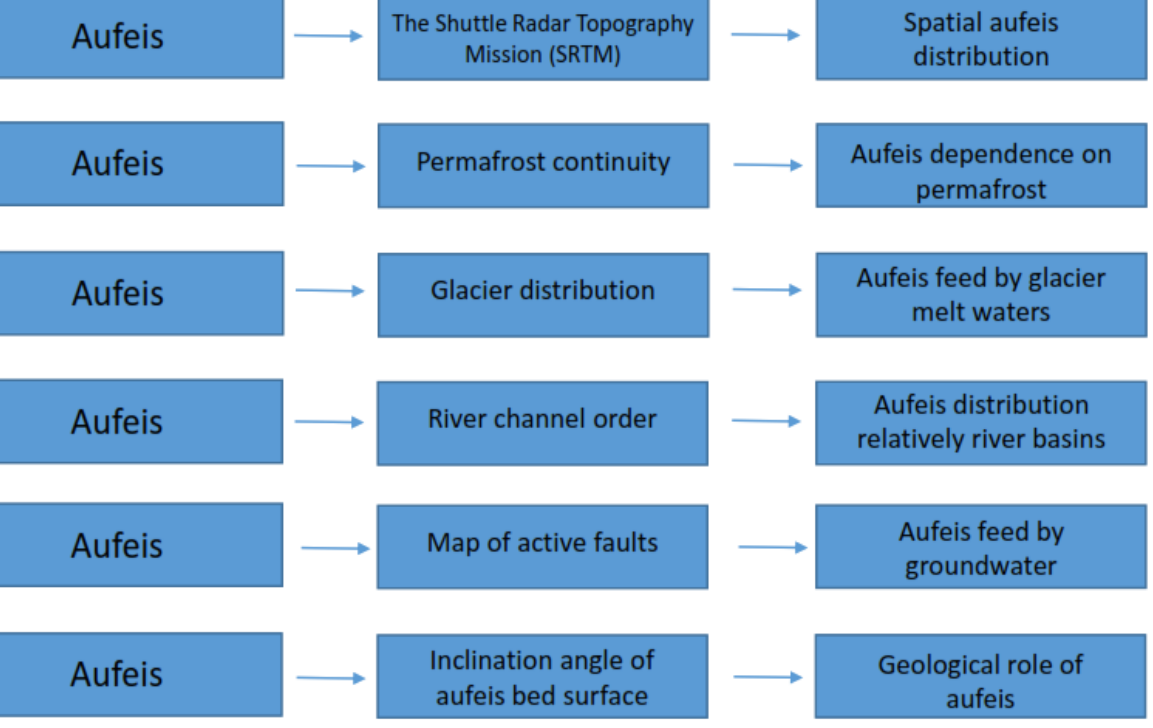
Figure 3. Algorithm of Aufeis data analysis.